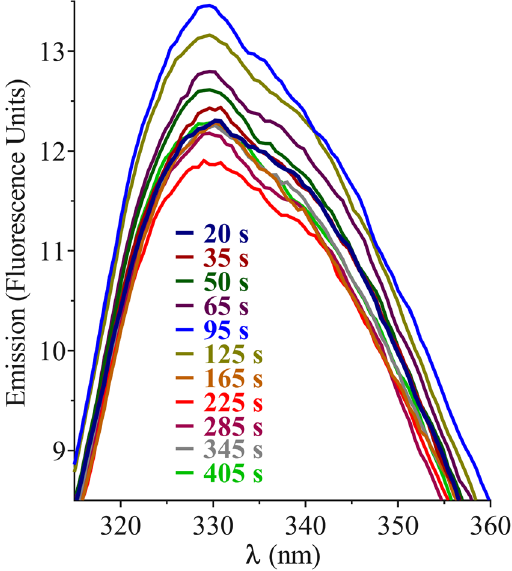
Figure 11. Intrinsic Trp fluorescence emission spectra upon incubation of 10 µ M peptide H3 with 1:1:1 POPC:POPE:POPS bilayer vesicles (100 µ M phospholipid) in 50 mM sodium acetate/140 mM NaCl buffer pH 4.5 at 25 °C. Each spectrum is the average of 3 scans, and differences in λ max and Emission max were not significantly different (P > 0.05). Overlapping scans are omitted for